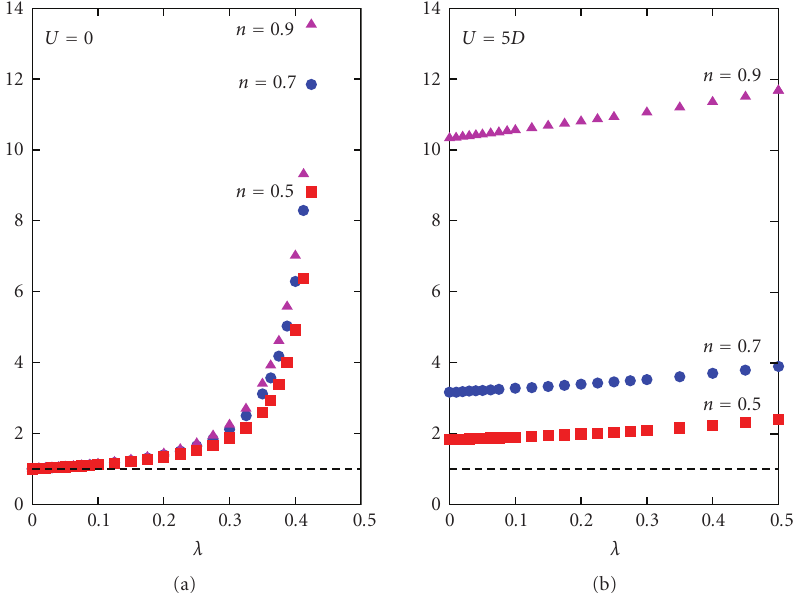
Figure 7: E ff ective mass m ∗ = 1 /zm as a function of λ for three di ff erent densities di ff erent from half-filling ( n = 0,5,0 . 7,0 . 9) in the uncorrelated (a) and strongly correlated ( U = 2 . 5 W , (b)) system (after Sangiovanni et al. [46]).